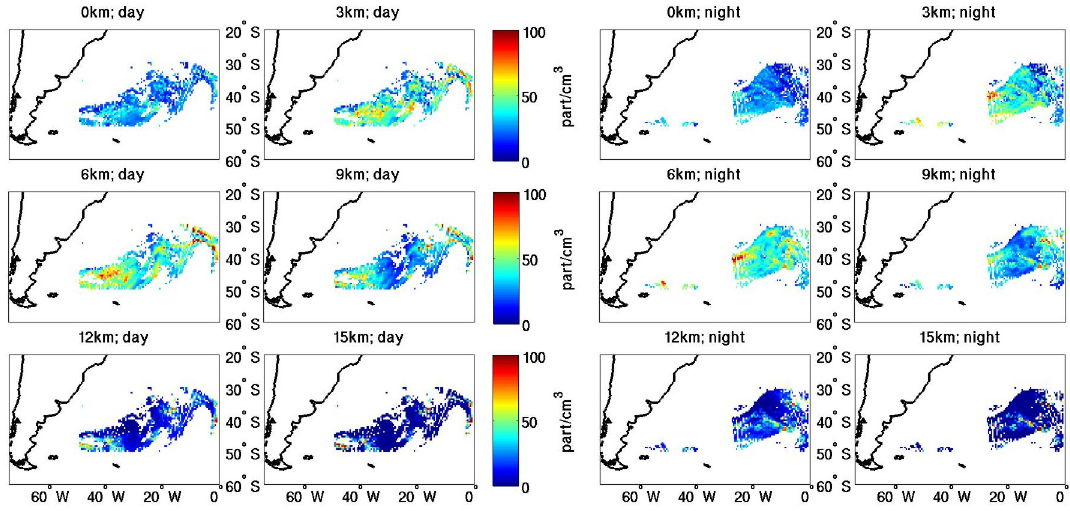
Figure 12. Ash concentration at the different retrieval altitudes for 16 June